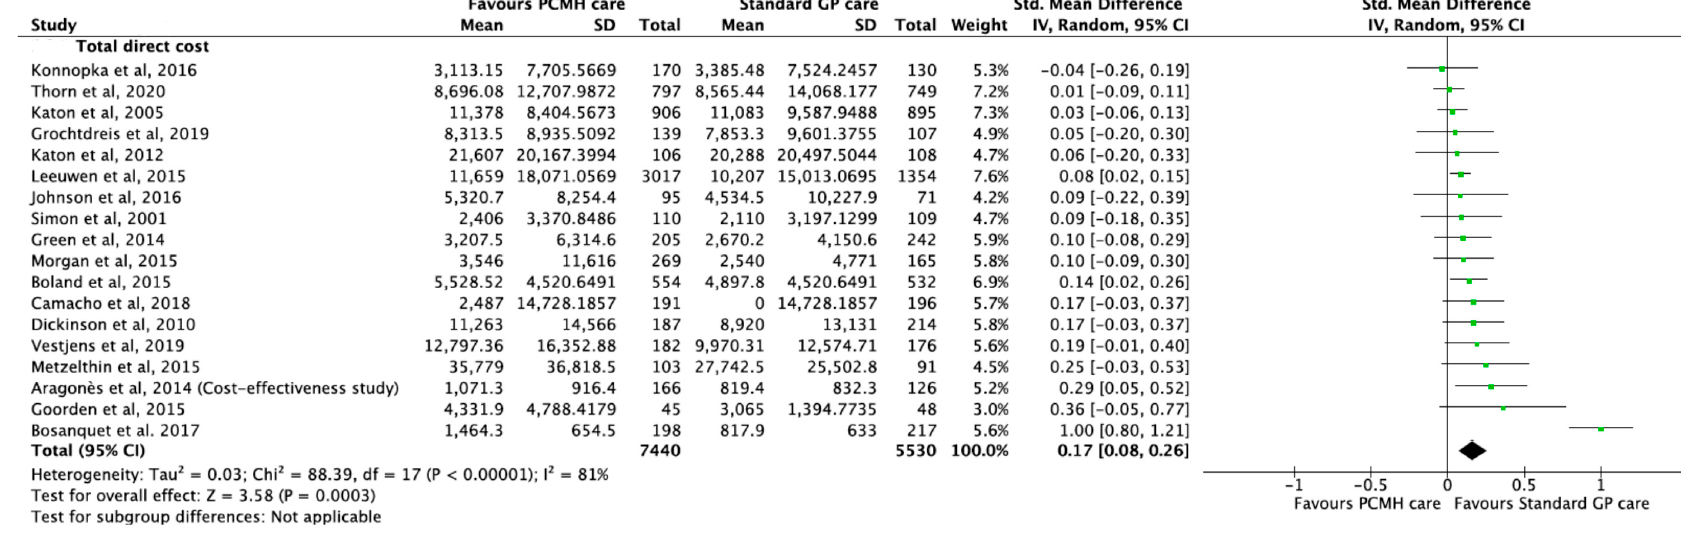
Figure 10. Forest plots of incremental cost of intervention between the PCMH care and Standard GP care. Table 2. Summary of findings from meta-analyses (where possible) or individual studies from randomised and non-randomised controlled trials.